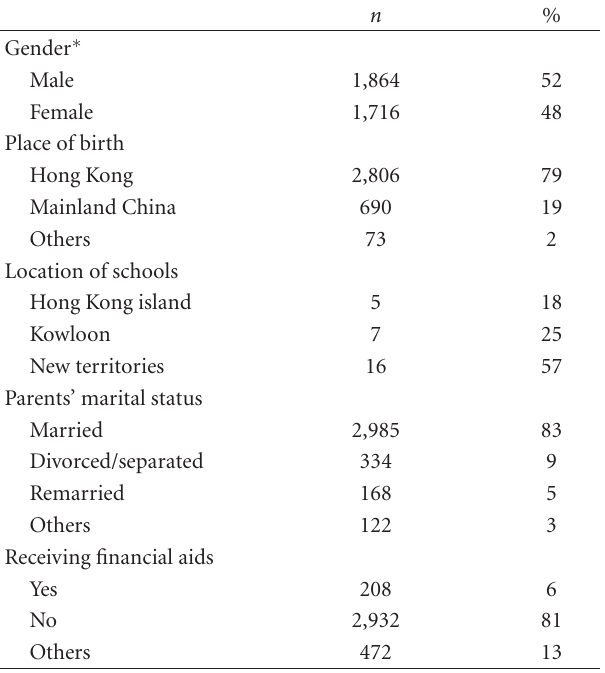
Table 1: Demographic information of the respondents ( N =